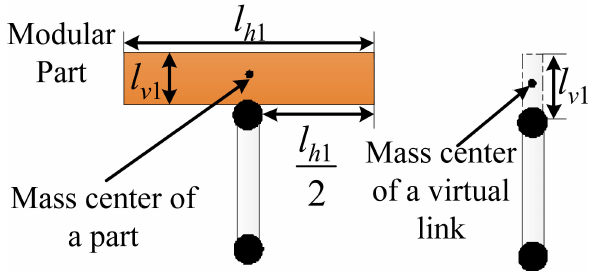
Figure 3. A modular part transformed to a virtual